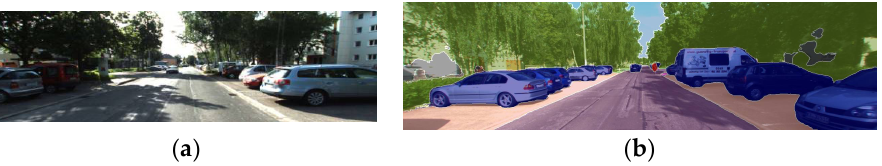
Figure 15. KITTI-360 Dataset Example: ( a ) KITTI-360 original image. ( b ) Segmentation label image.